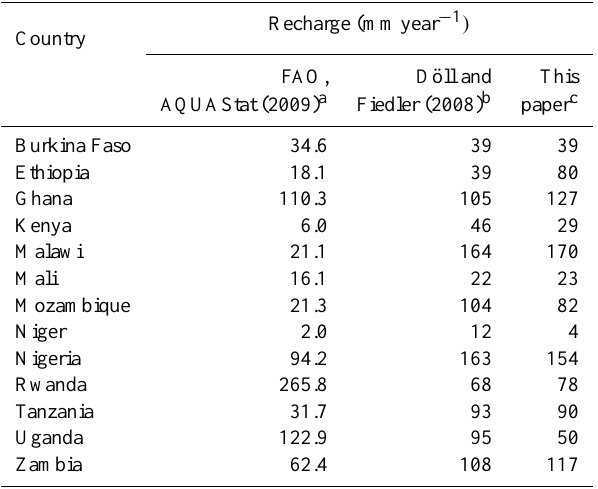
Table 5. Comparison of estimations of groundwater recharge for selected African